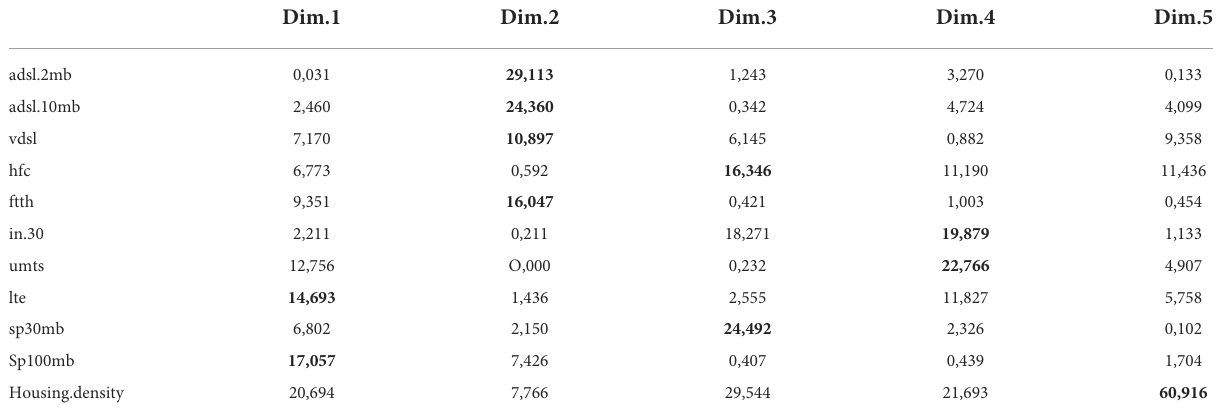
TABLE 3 Contributions of technology–related variables. Dim.1 Dim.2